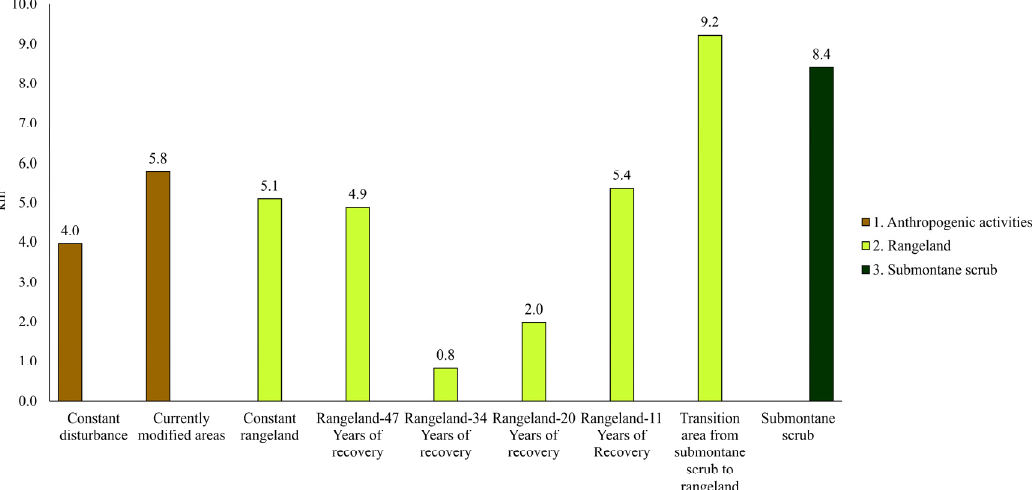
Figure 9. Represented area (km 2 ) for each category of land use coverage during the study period, San Antonio, Jaumave, Tamaulipas, Mexico.